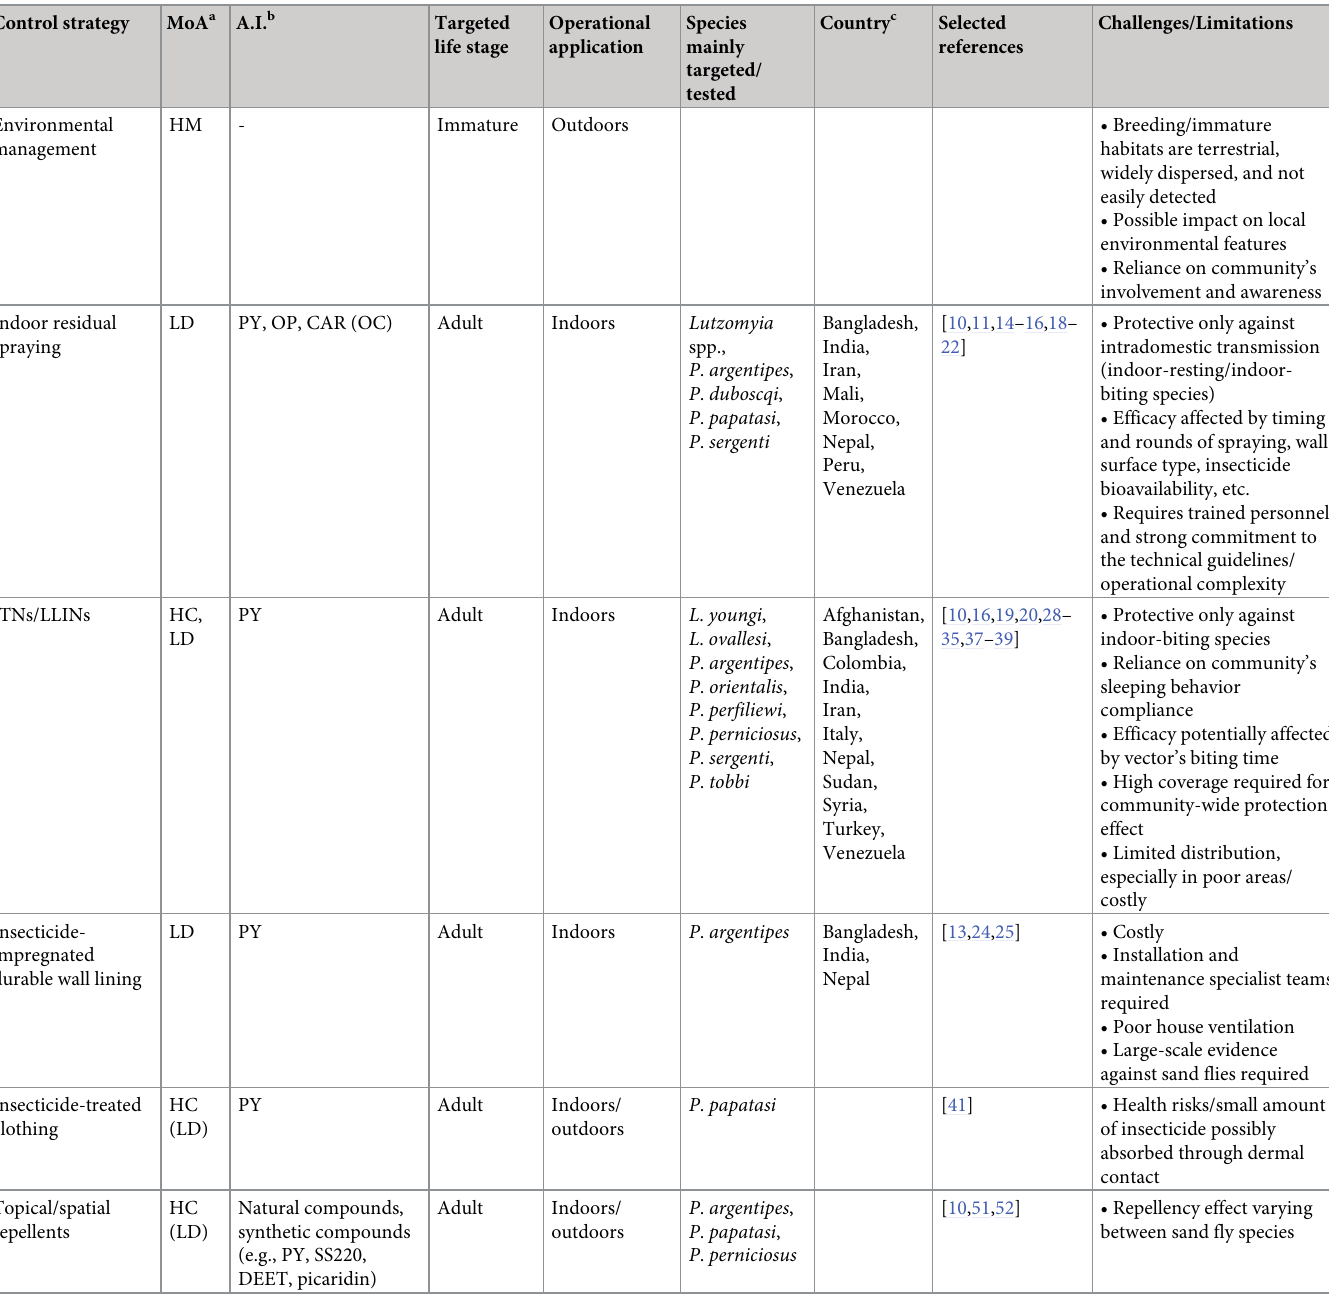
(Table 1). The intervention’s operational success relies on multifarious parameters, including commitment to the technical guidelines by properly trained spraying personnel, effective ground program supervision, the type of wall surface treated/sprayed, the quality and residual Table 1. Summary description of sand fly vector control practices discussed in the present review article and associated